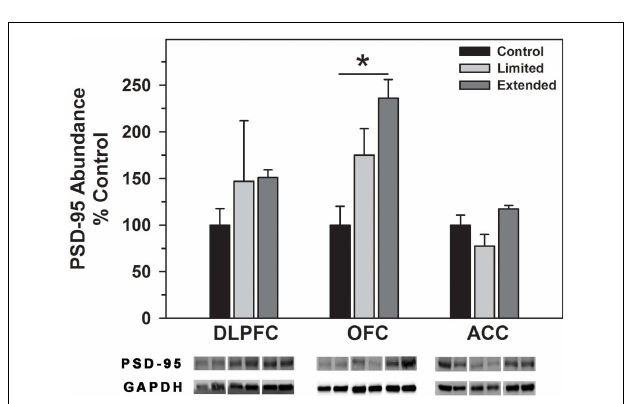
FIGURE 6 |Western blot analysis of PSD-95 protein levels in prefrontal regions following limited and extended access to cocaine self-administration . Cytosolic fractions were isolated as described in the Section “Materials and Methods” and 10 µ g were separated on 10% SDS-PAGE. Data are expressed as mean ( ± SEM) of the percent of control values per amount of protein loaded. Asterisks indicate a significant difference ( P < 0.05). Bottom Panel: Representative bands from two subjects per group per